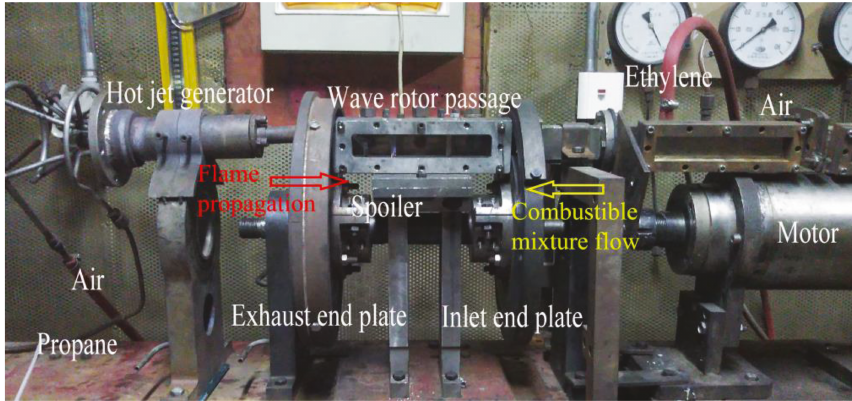
Figure 3: An experimental rig of a WRC.